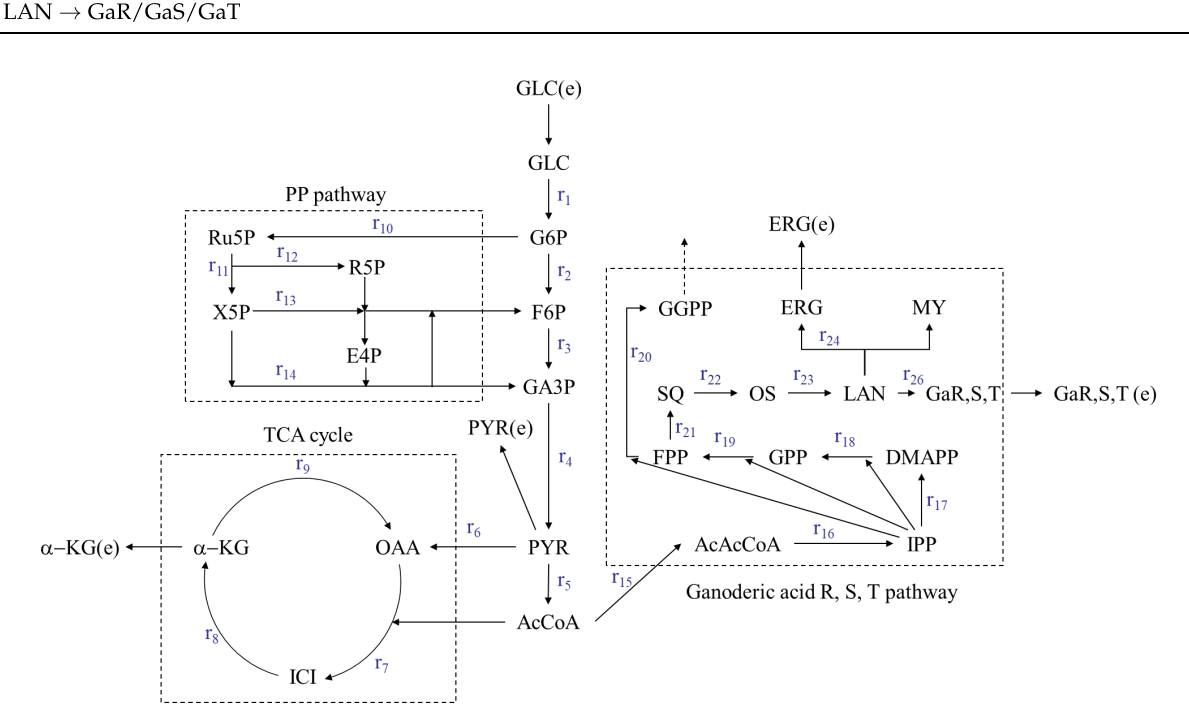
Figure 2. The metabolic network of ganoderic acids R, S and T synthesis by G. lucidum, submerged